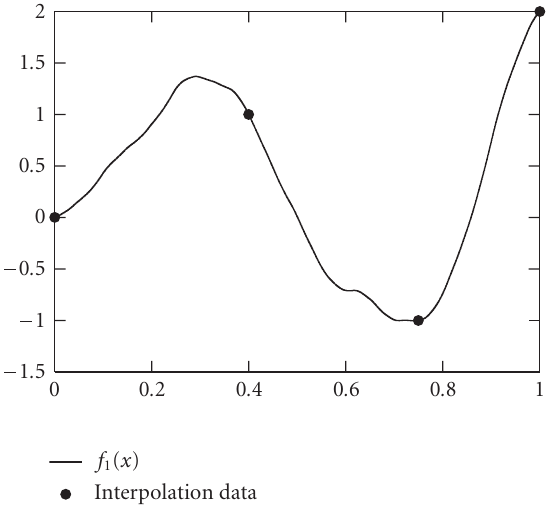
Figure 5.1. Spline CHFIF f 1 ( x ) for